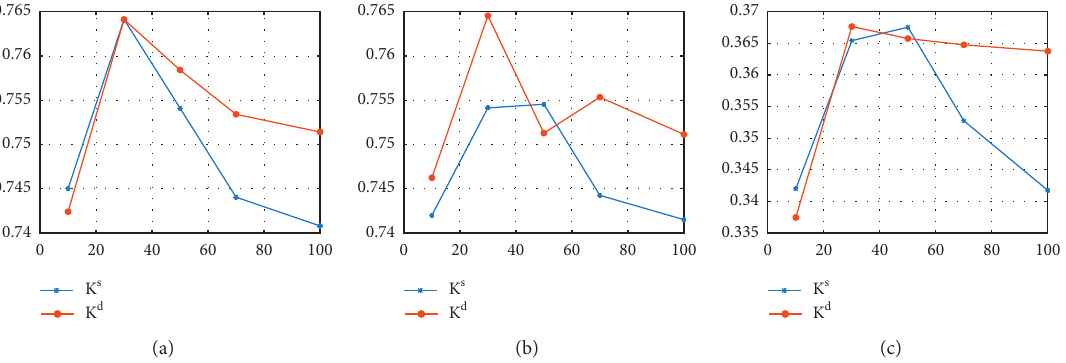
Figure 8: Effect of product data sets K d and K s on model effects: (a) ROUGE-1, (b) ROUGE-L, and (c) BLEU-1.